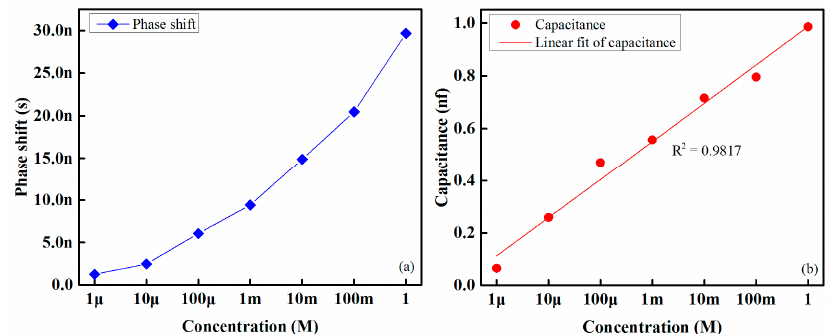
Figure 10. Behavior of the sensing element of the designed electronic tongue for various concentrations of glucose: ( a ) phase shift and ( b ) capacitance.